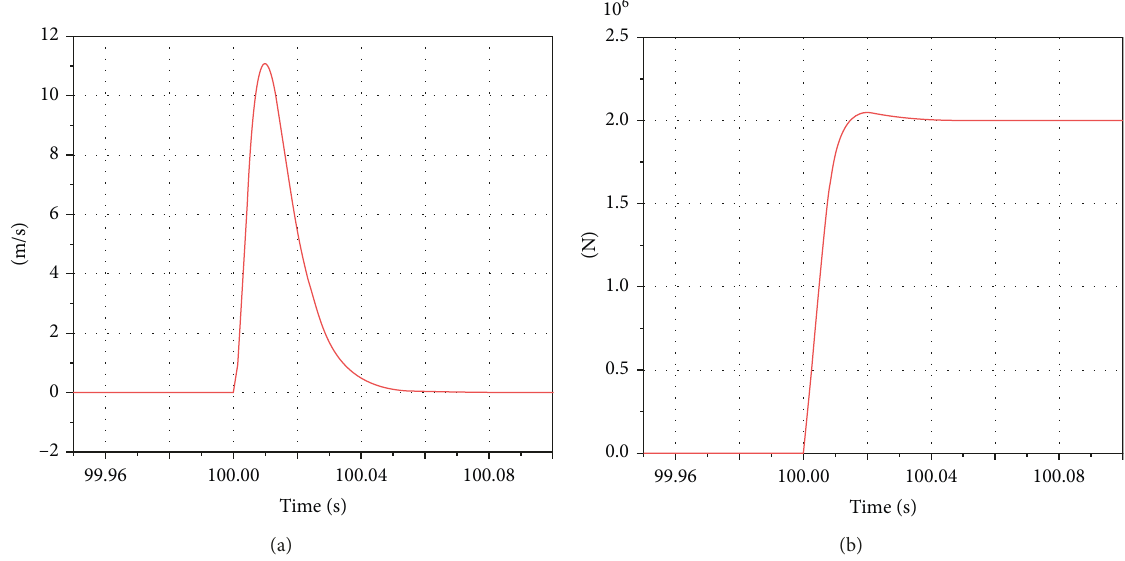
Figure 5: Simulation curves of impact velocity and force. (a) Impact velocity. (b) Impact force.